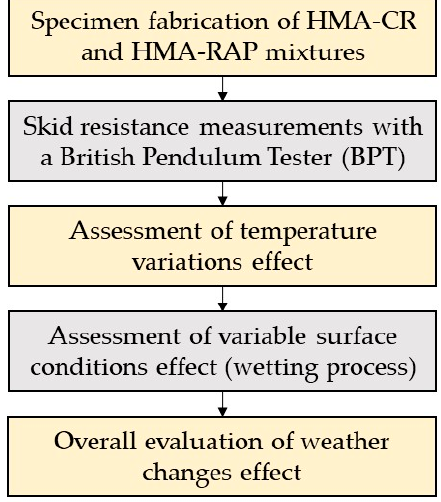
Figure 1. Study flowchart.